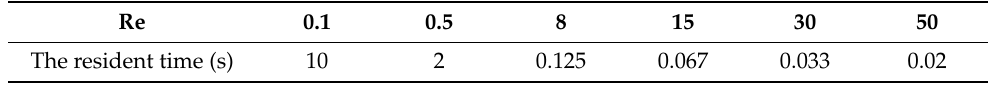
Figure 9. Nonlinear curve fitting of mixing efficiency and distance at ( a ) Re = 0.1, ( b ) Re = 0.5, ( c ) Re = 8, ( d ) Re = 15, ( e ) Re = 30 and ( f ) Re = 50. Table 2. The residence time of liquid in mixer under different Re values .